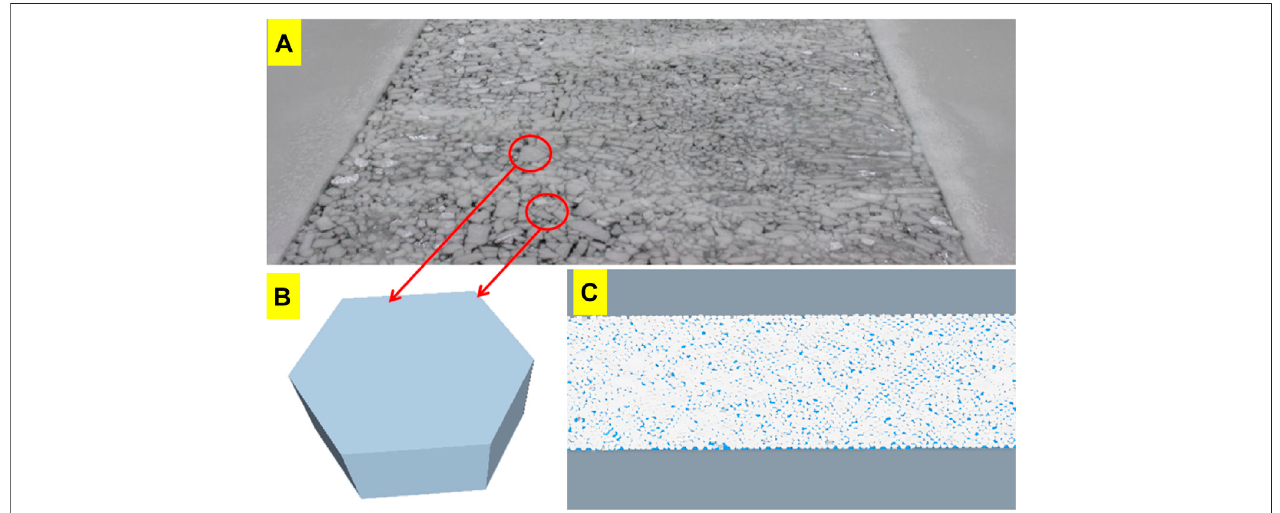
FIGURE 5 | Shape of the brash ice model and the arrangement of the brash ice channel. (A) Brash ice distribution image of the HSVA ice tank test; (B) hexagonal brash ice model; (C) channel arranged by hexagonal brash ice.